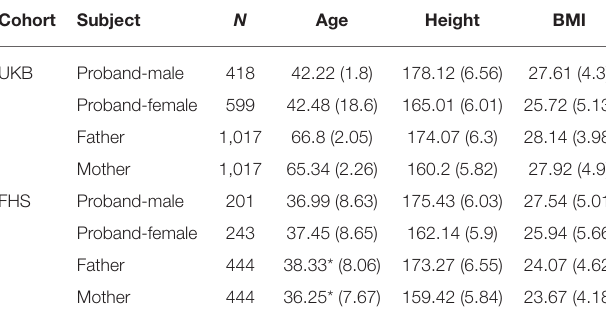
TABLE 1 | Characteristics of study